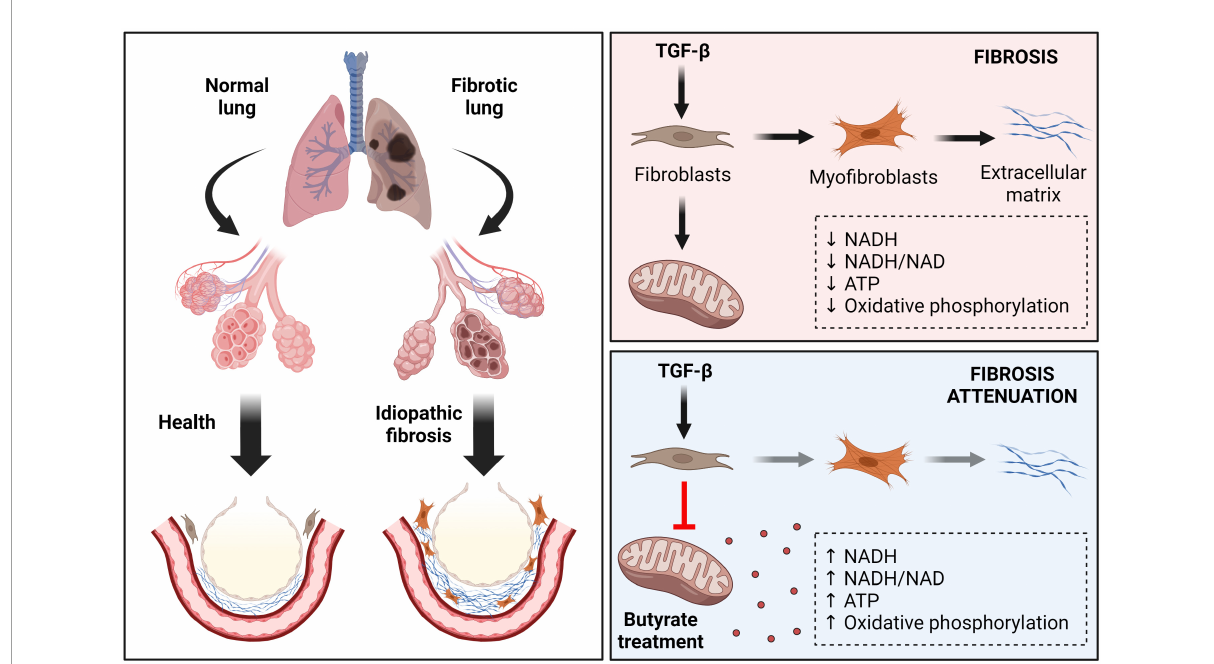
FIGURE3 Effects of butyrate in idiopathic pulmonary fibrosis (IPF). IPF is a chronic, progressive, and fibrotic lung disease. Healthy tissue is replaced by an extracellular matrix (ECM) composed by collagen in a TGF- β dependent way. In this condition the alveolar architecture is compromised, leading to decreased lung compliance, disrupted gas exchange, and respiratory failure. TGF- β alters the metabolism and induces pulmonary fibroblasts differentiation, lowering their mitochondrial NADH, NADH/NAD, and ATP levels, as well as oxidative phosphorylation activity. Butyrate acts as a potent antifibrotic factor, restoring mitochondrial activity, and affecting myofibroblast differentiation. TGF- β , transforming growth factor beta; NAD, nicotinamide adenine dinucleotide; NADH, nicotinamide adenine dinucleotide + hydrogen; ATP, adenosine